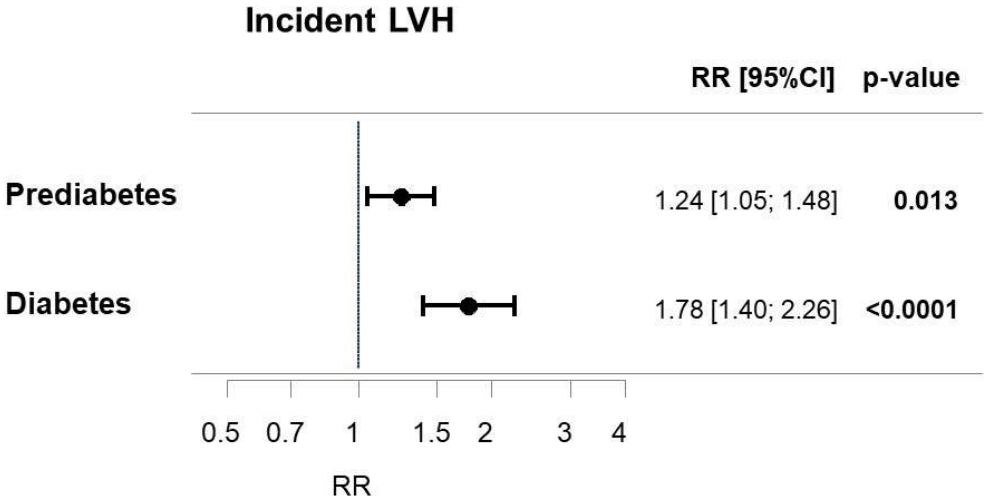
Figure 2. Mortality by diabetic state and presence of LVH. Compared all-cause mortality ( A ) and cardiovascular mortality ( B ) regarding diabetic state in individuals with and without left ventricular hypertrophy (LVH). Mortality in individuals with prediabetes and LVH was as high as in diabetes without LVH. A total of 808 deaths were registered within a median observational follow-up time of 9.04 years (IQR 7.7–10.0 years). In 12,958 individuals without LVH, 596 deaths including 117 fatal cardiovascular events were recorded, and of 1791 individuals with LVH 205 deaths were notified (60 events of cardiovascular reasons). The p -value of the log-rank test is given in the figure.